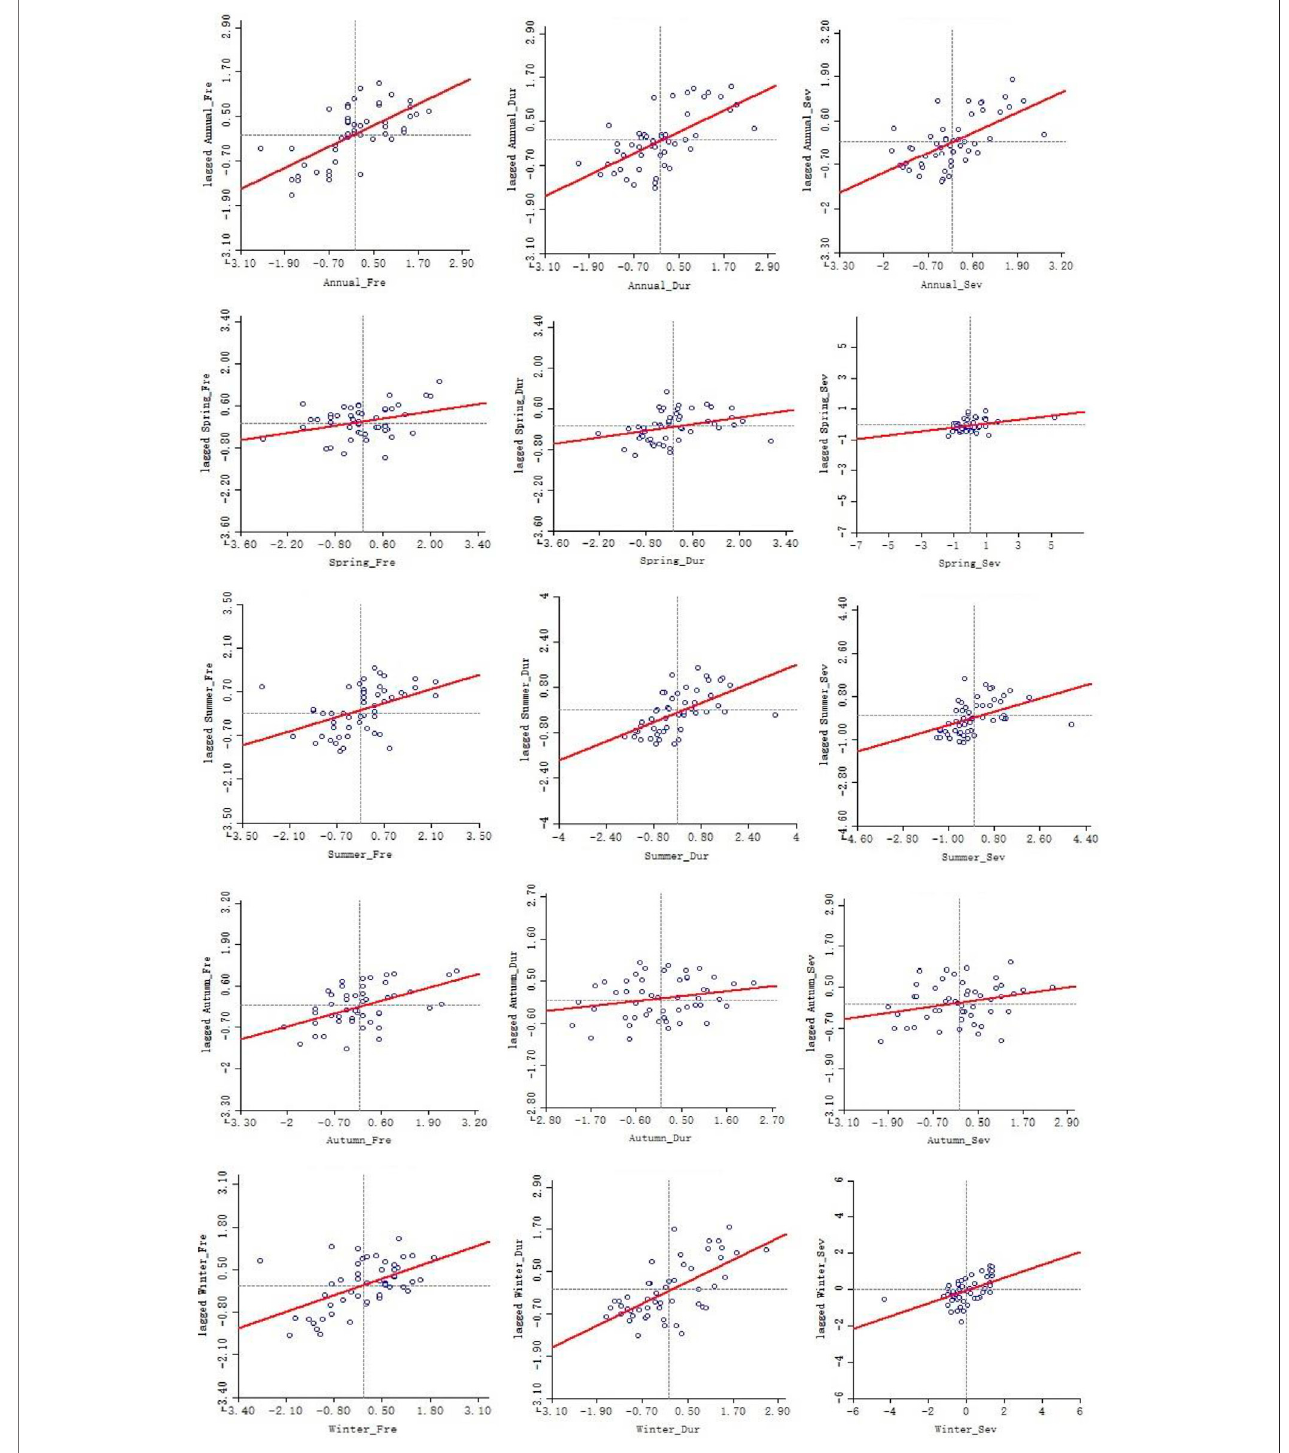
FIGURE 13 | Scatter plots of LMI for the drought characteristic variables.